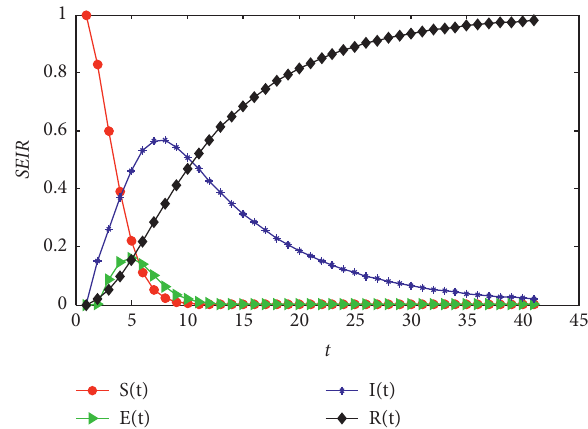
Figure 7: Change trend of SEIR model (2) (when μ 1 � 0.7, μ 2 � 0.1, μ 3 � 0.02, α � 0.5, and c � 1, the change of four independent states of the credit subject trend over time).